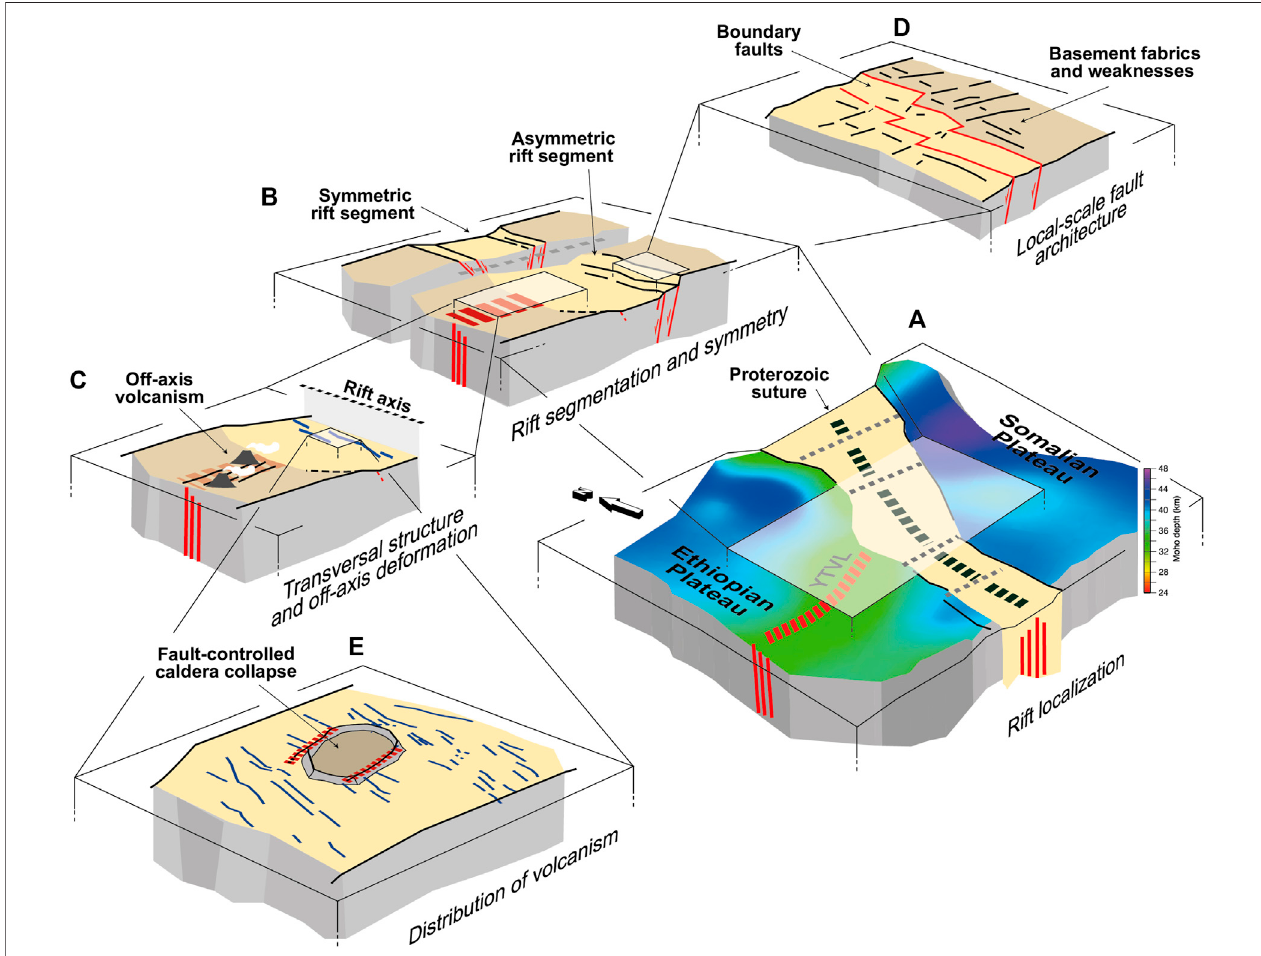
FIGURE13| SchematicillustrationofthecontrolexertedbyinheritedheterogeneitiesatdifferentscalesintheMER.Fromregional-scaletolocal-scale,weobserve: (A) Rift localization controlled by Proterozoic suture. YTVL: Yerer-Tullu Wellel transversal structure; (B) Rift segmentation and asymmetry induced by large-scale transversal structures; (C) Off-Axis volcanism controlled by large-scale transversal structures; (D) Local-scale architecture controlled by inherited basement fabrics; (E) Distribution and setting of volcanism controlled by local scale-inherited structures.